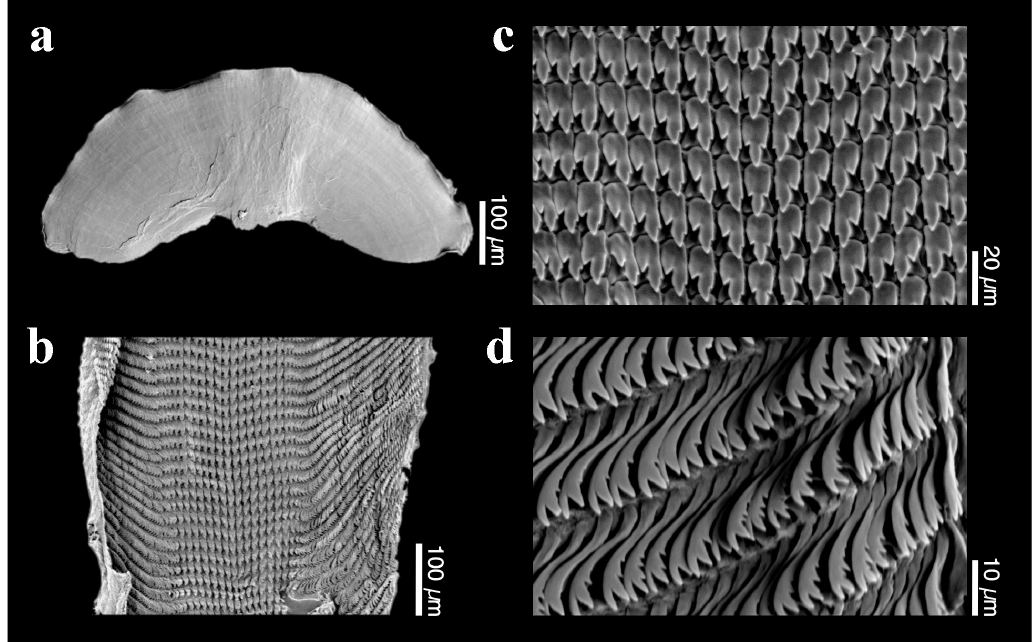
Figure 4 - Scanning electron micrographs of jaw and radula of Ovachlamys fulgens . a, jaw; b, radular segment; c, detail showing central and lateral teeth; d, marginal